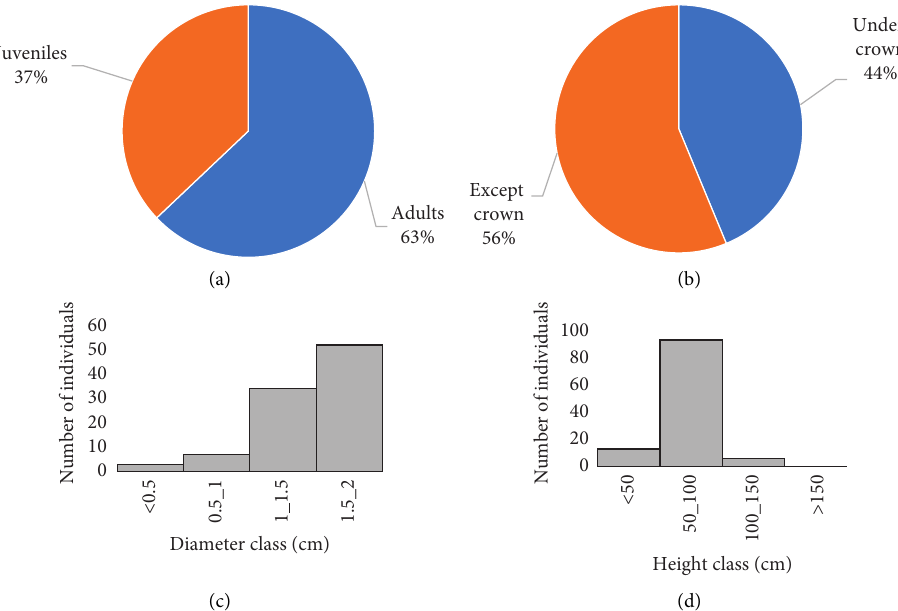
Figure 2: Structure of natural regeneration of Balanites aegyptiaca at the Regional Centre for Agricultural Research (CERRA), Maradi, Niger. Distribution of the total number of adults and juveniles (a), exposure (b), diameter structure of the juveniles (c), and height